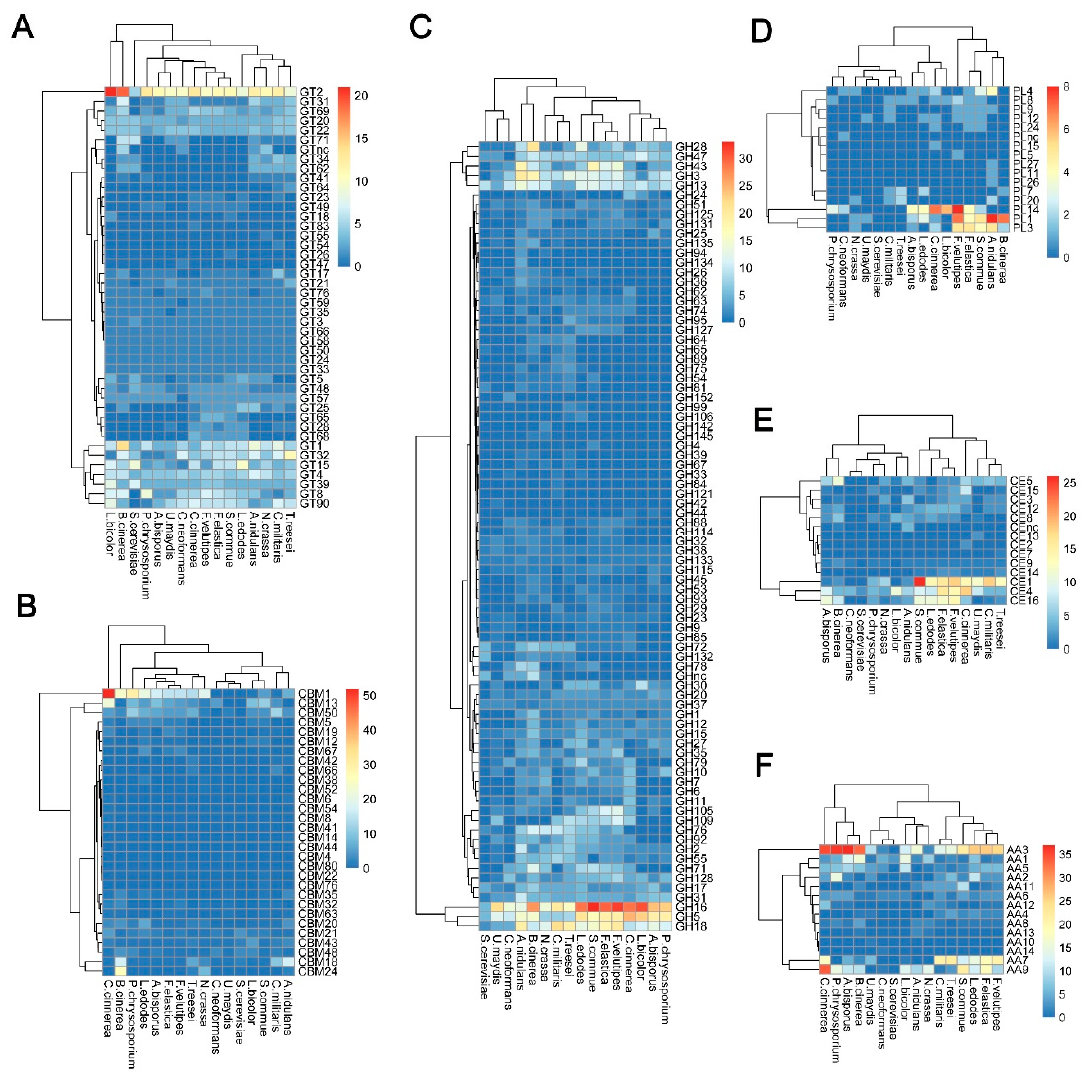
Figure 6. Distribution of CAZymes in F. elastica and other fungal species. ( A ) GT families; ( B ) CBM families; ( C ) GH families; ( C ) PL families; ( E ) CE families; ( F ) AA families.